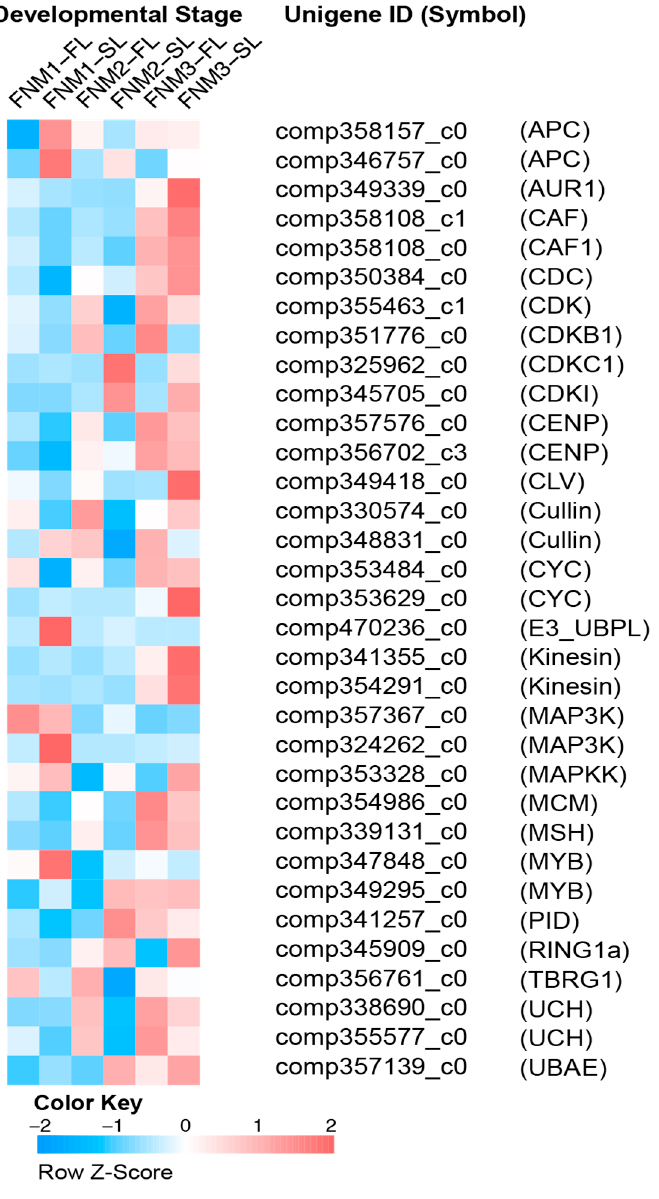
Figure 4. Specific temporal changes of cell cycle-associated genes during FNM. For the full names and expression and annotation data of the genes, see Tables S2 and S5. Data for the gene expression level were normalized to Z-score.